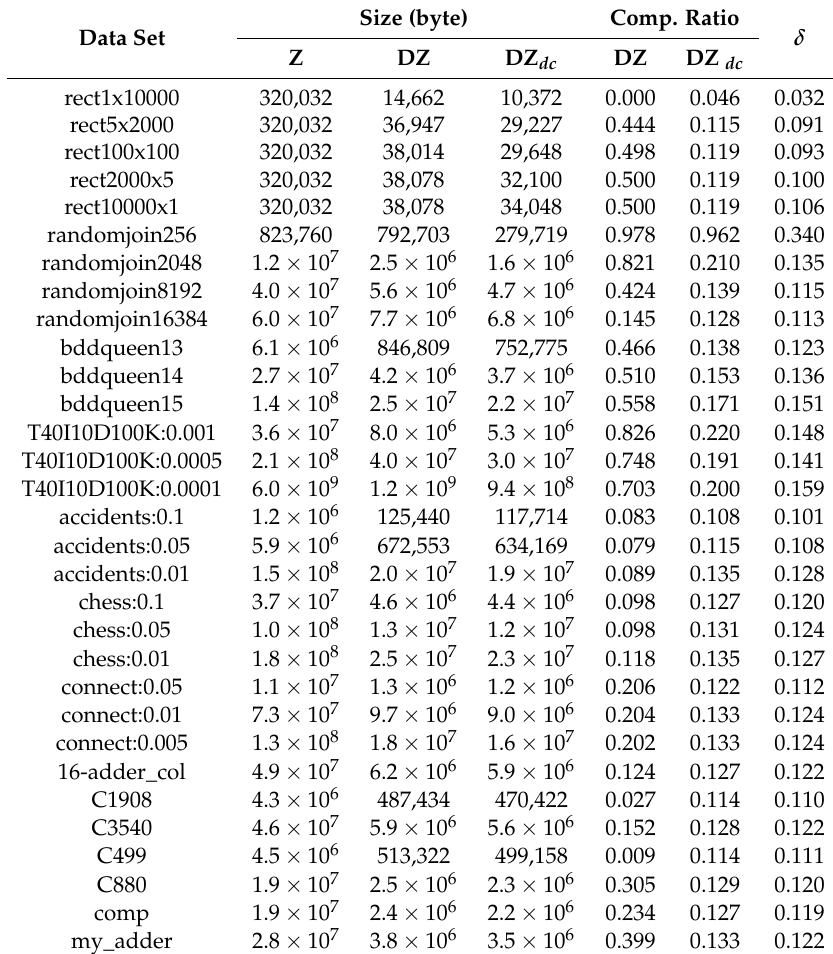
Table 3. Comparison of performance, where δ denotes the dummy node ratio. Z , DZ , and DZ dc indicate ordinary ZDDs, DenseZDDs and dummy-compressed DenseZDDs,